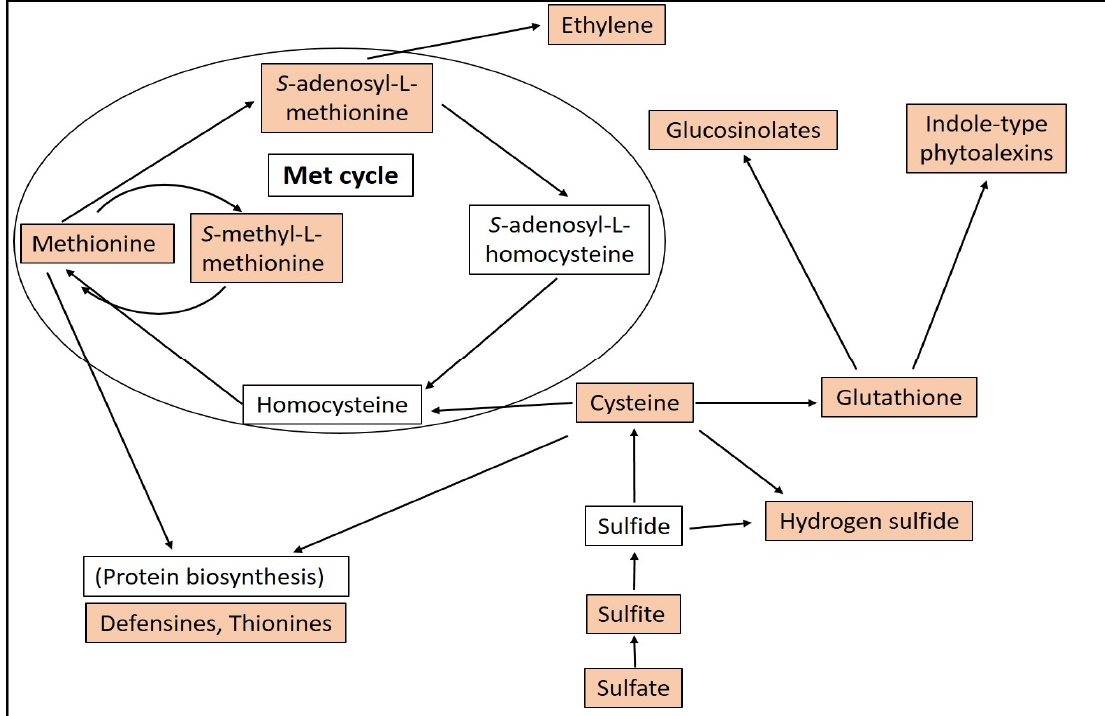
Figure 1. Schematic representation of biosynthetic pathways of the most important sulfur-associated compounds in plants. Sulfur-associated compounds mentioned in this review are highlighted.